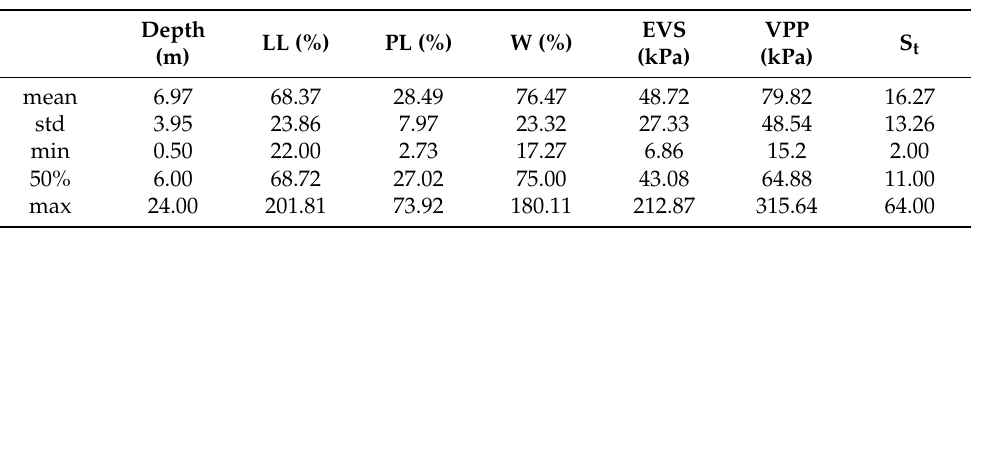
Table 1. Statistical information of clay